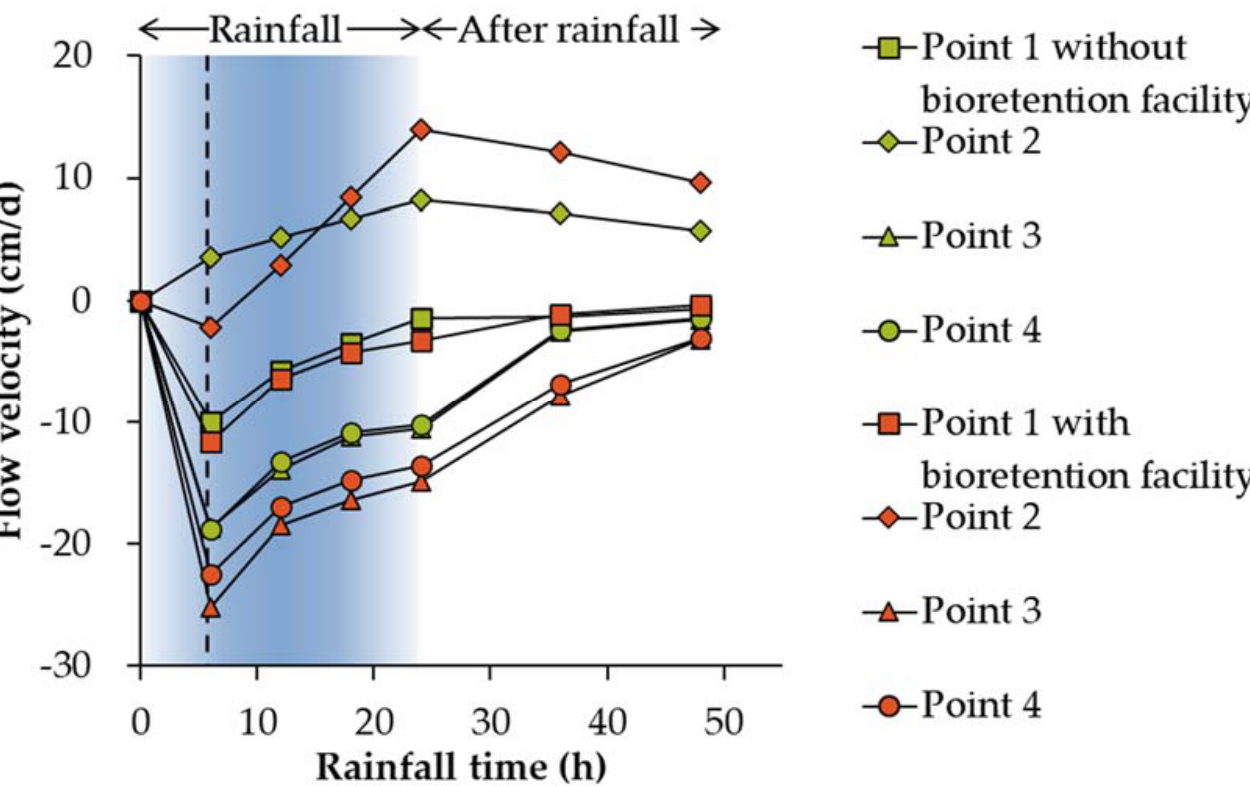
Figure 8. Flow velocity curves of different control points.